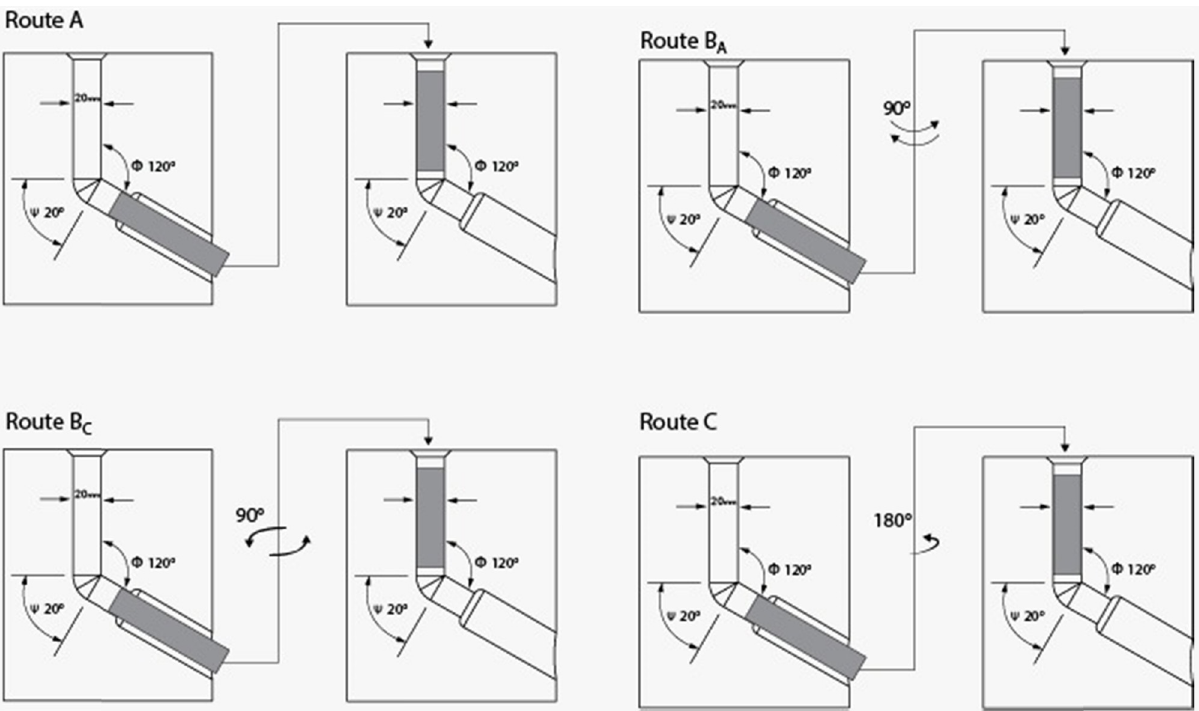
Figure 1: Schematic of the di ff erent routes type of ECAP